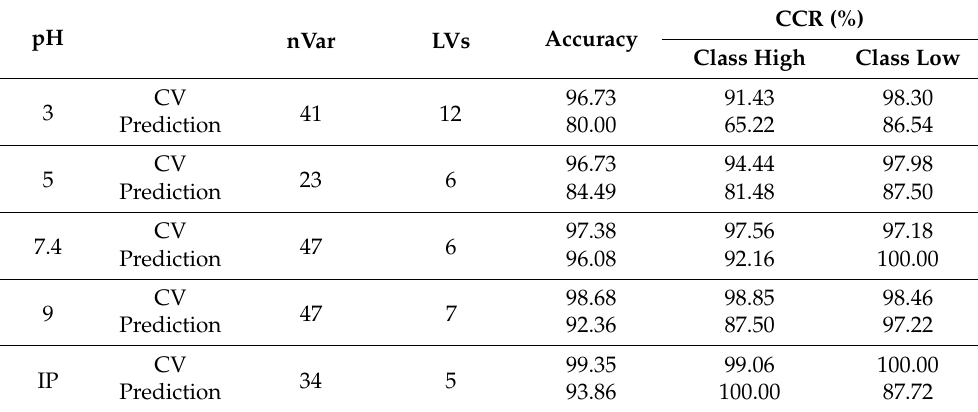
Table 4. PLS-DA of the five investigated datasets after variable selection by CovSel: Number of selected descriptors (nVar), number of latent variables (LVs), overall accuracy and correct classification rate (CCR%) on the training data in cross-validation (CV) and on the test set in prediction. pH